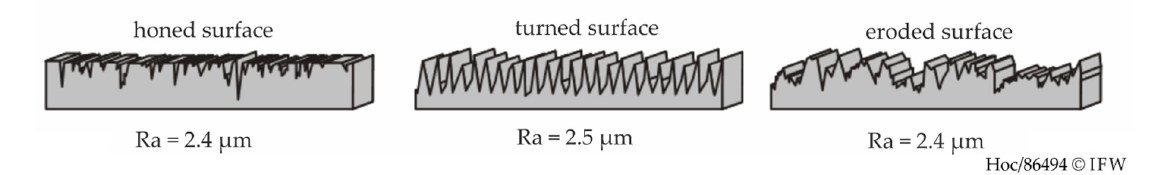
Figure 1. Different characteristics of surfaces with same roughness value [17] .